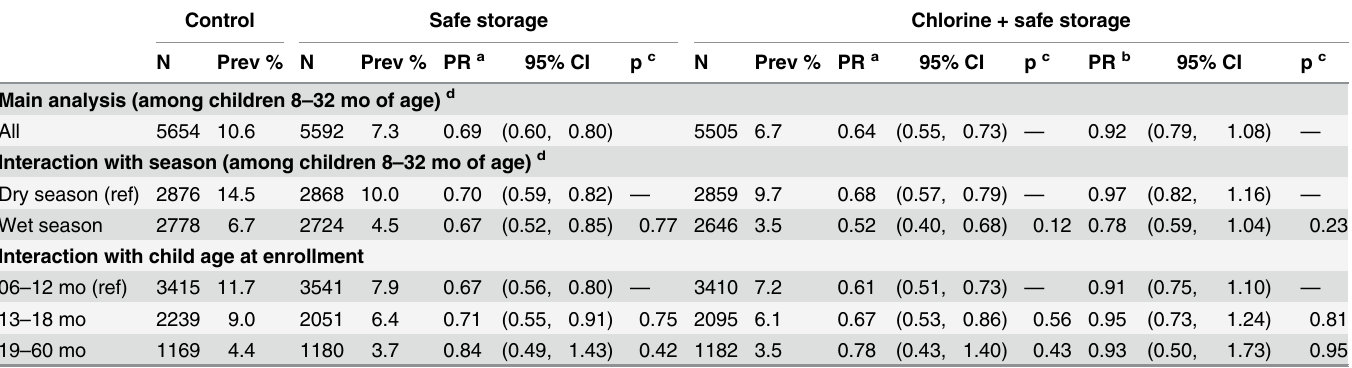
Table 3. Prevalence of diarrhea across study arms (7-day recall